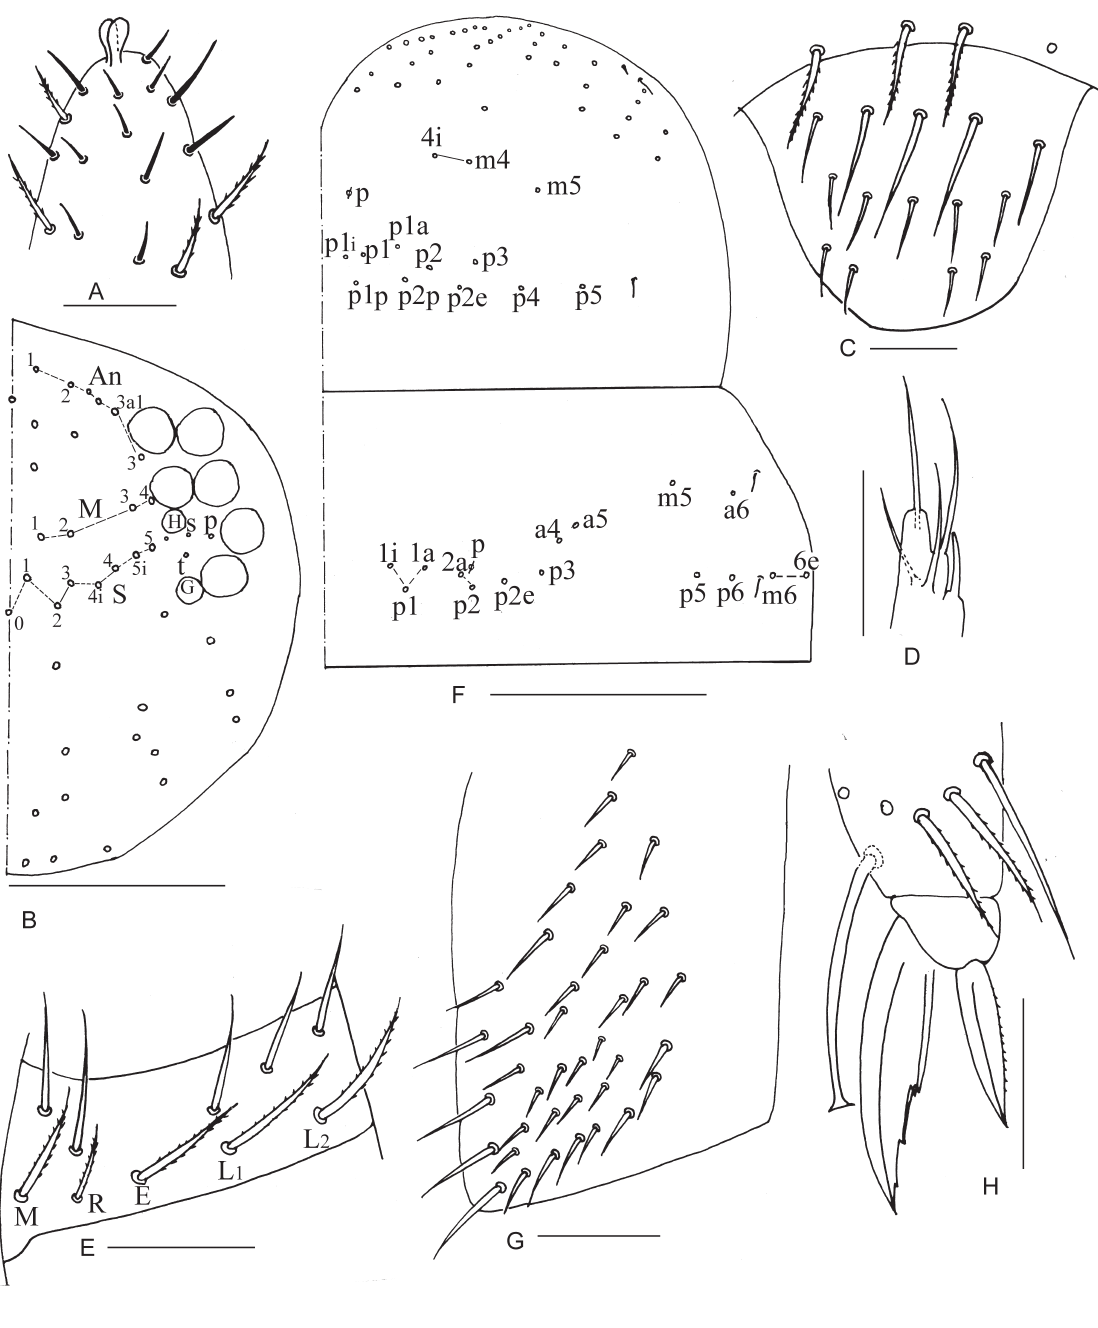
Fig. 2. Willowsia sexachaeta sp. nov. A . Apex of Ant. IV. B . Dorsal chaetotaxy of head. C . Labrum. D . Lateral process of labial palp. E . Labium. F . Chaetotaxy of Th. II−III. G . Trochanteral organ. H . Foot complex. Scale bars: A, C−E, G–H = 20 μm; B, F = 100